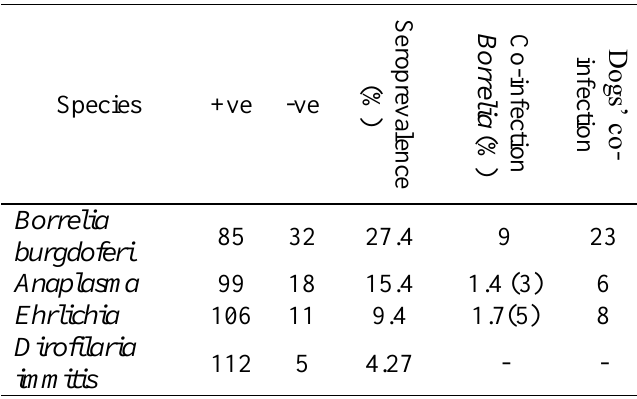
of other pathogens as for Anaplasma , 20.2% for Ehrlichia and 8% for Dirofilaria immitis (Table 2).